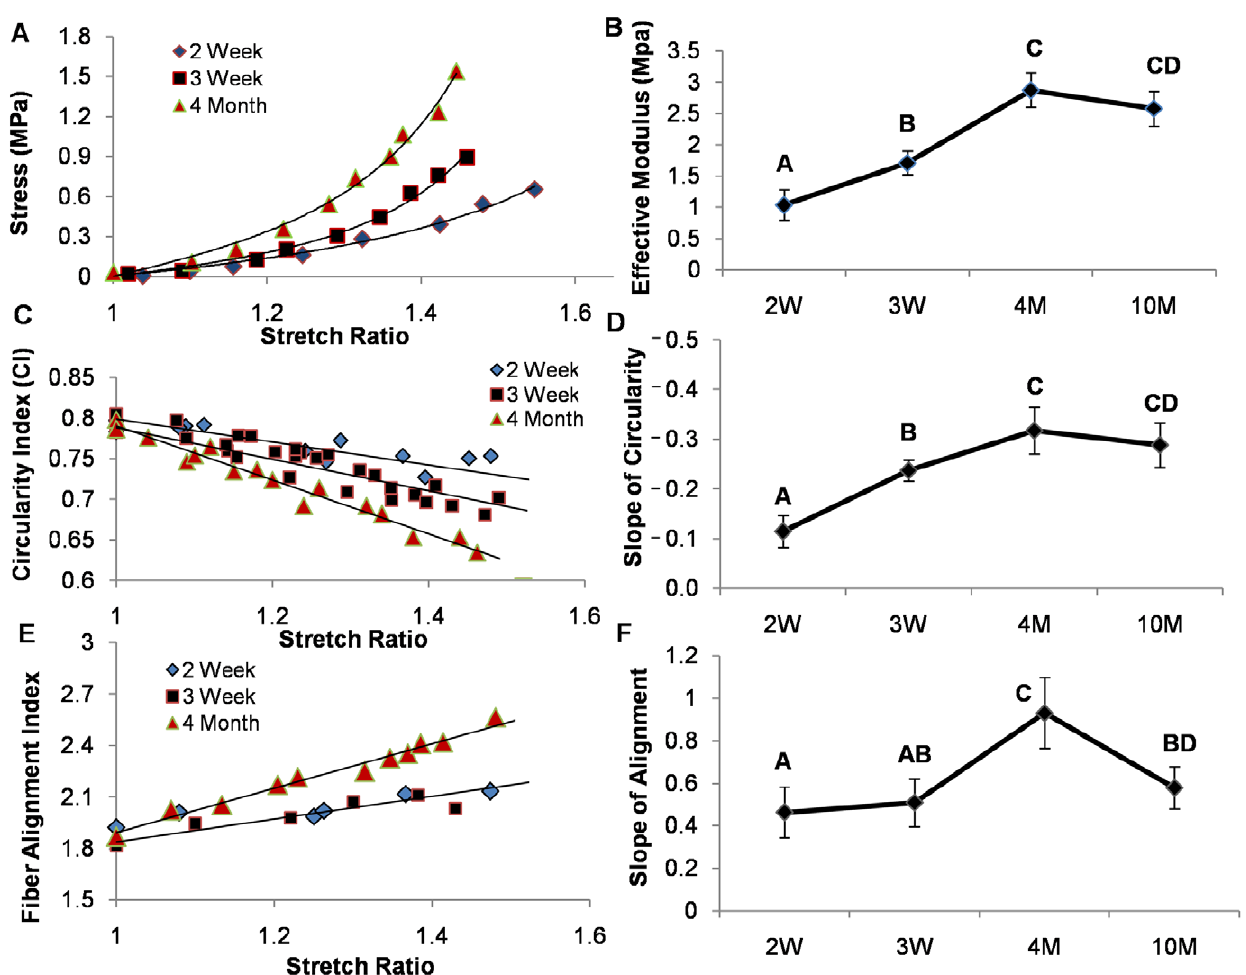
Figure 3. Temporal biomechanical analysis of C57/B6J mitral valves. (A) Representative stress-strain curves of mitral valves loaded in the circumferential direction (not to failure). (B) Stress-strain data were fit to an exponential Fung model, from which coefficients were used to determine effective modulus. (C) Representative circularity index curves as defined by the ratio of 4*Pi*(Area/Perimeter 2 ). (D) Circularity-index curves were modeled as a linear fit and the negative slope was used for comparison. (E) Representative fiber-alignment curves were defined by the Fourier- Transform of collagen alignment and summed within ten degrees of the image horizontal, which was parallel to the tissue and loading direction. (F) Fiber-alignment data were fit to a linear model, the negative slope of which was used for comparison. Error bars show 6 SD, n $ 6 for each condition. Groups that do not share letters are significantly different from each other according to a one-way ANOVA with Tukey’s post hoc (p # 0.05).